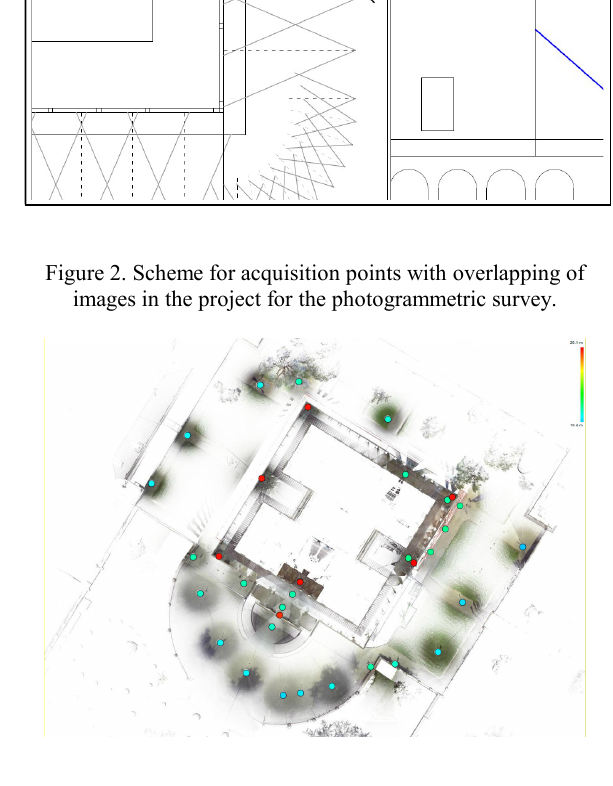
Figure 3. The main survey plan, indicating the positions of all the 35 acquired scans around the